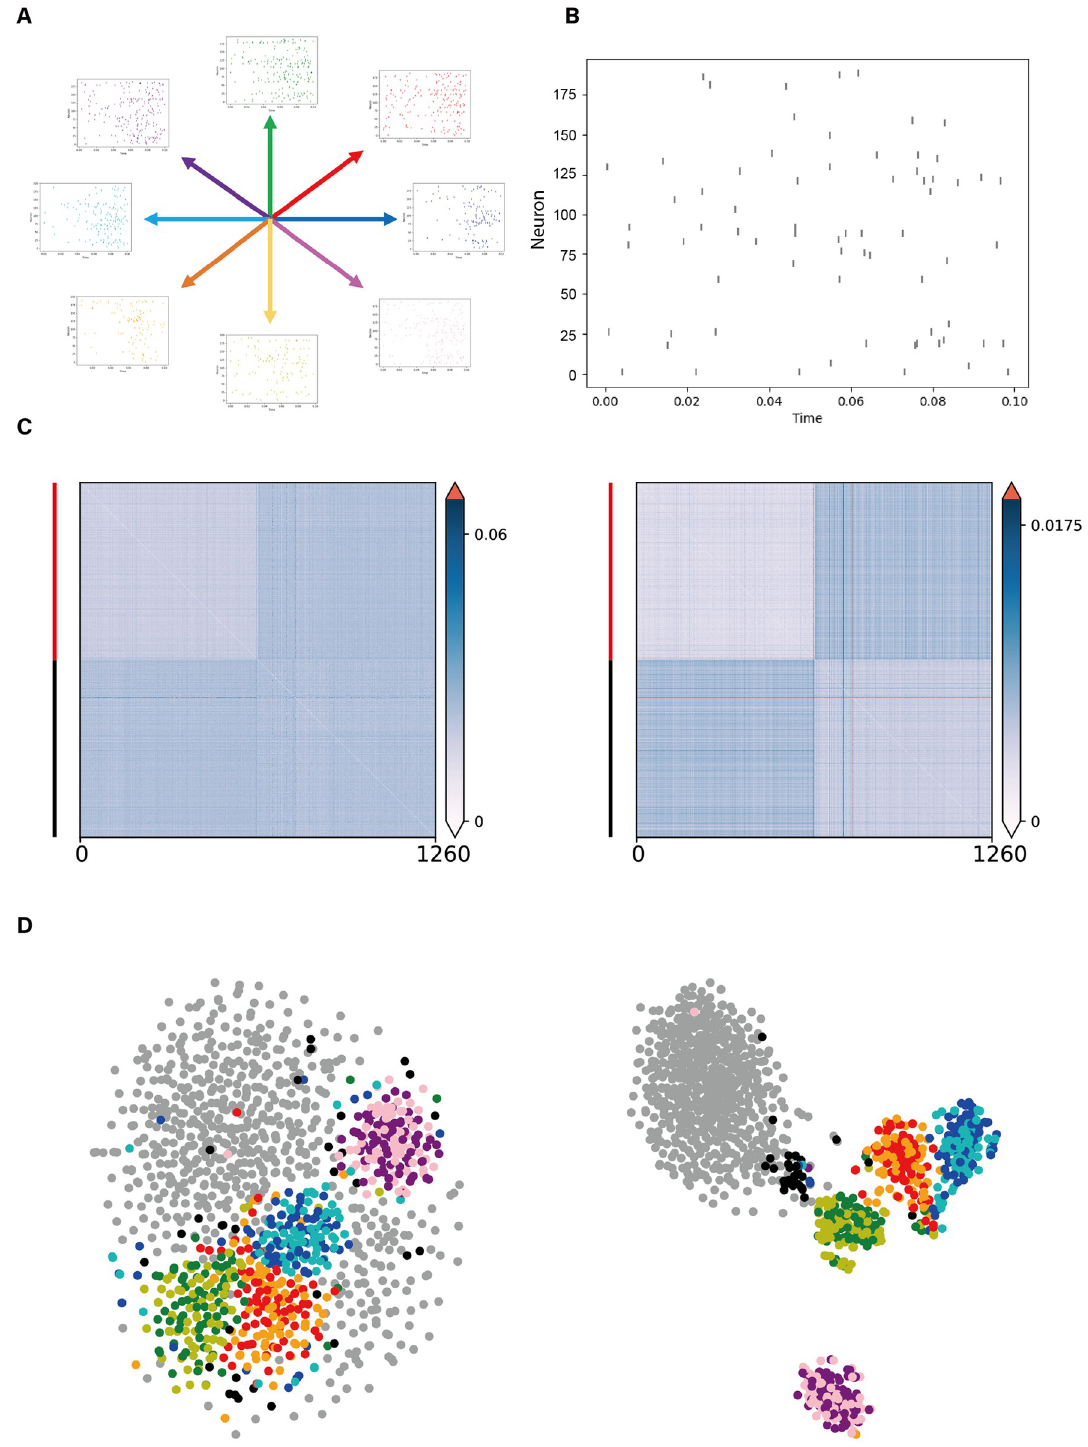
Fig 5. DoD transformation improves clustering of neural spiking sequences. A : Example raster plot of spiking pattern to drifting gratings of eight different directions. We analyzed the spiking events in the time window of 100 ms after the stimulus onset. B : Example raster plot of spontaneous neural response. We analyzed the spiking events in the time window of 100 ms in intertrial intervals (number of neurons: 191). C : Pairwise distances between all spiking patterns. Left , Original SPOTDist matrix between spiking patterns. SPOTDist is a distance measure that compares the similarity of the spiking patterns based on optimal transport distance (i.e. the